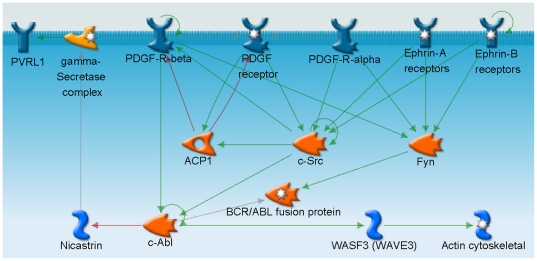
Protein-protein interaction between the products of the EF-regulated genes associated with adherens junction.The diagram showed that the EF up-regulated Fyn, ACP1, and c-Src might directly interact with two kinds of membrane receptors, PDGF receptors and ephrin receptors. Green arrow: positive effect; Red arrow: negative effect; gray arrow: unspecified effect.